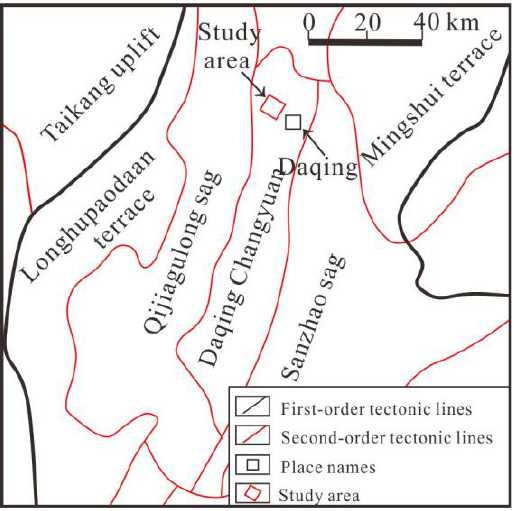
Figure 1. Regional location map of the Daqing Changyuan oilfield.